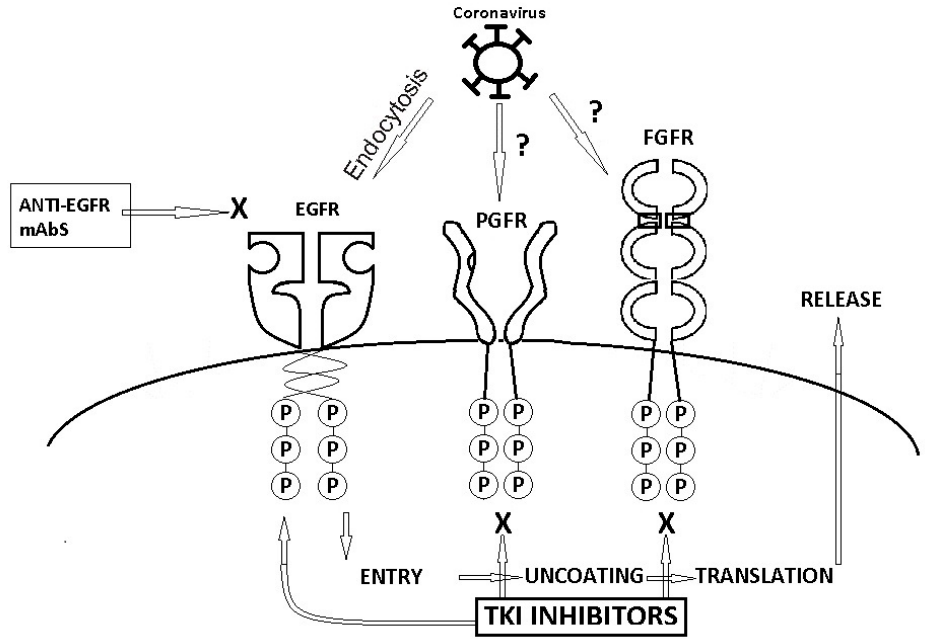
Figure 1. The potential role of several GFRs in coronavirus infection.